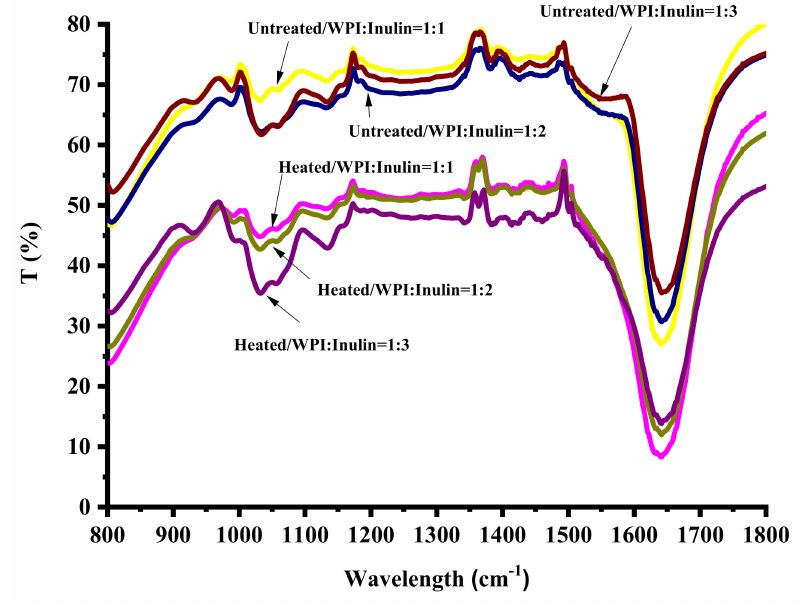
Figure 8. FT-IR spectra of whey protein and inulin mixture before and after dry heating.